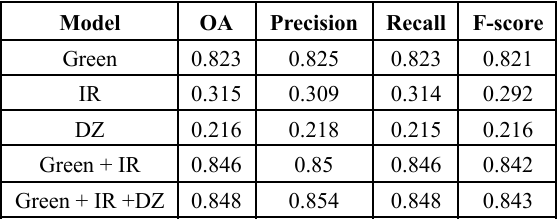
Table 3. Classification performances for different predictors. Overall, the most relevant predictors for the classification of coastal land and sea covers are descriptors of the green lidar waveforms. IR data or differential elevation values appear to misclassify more than two thirds of the points.